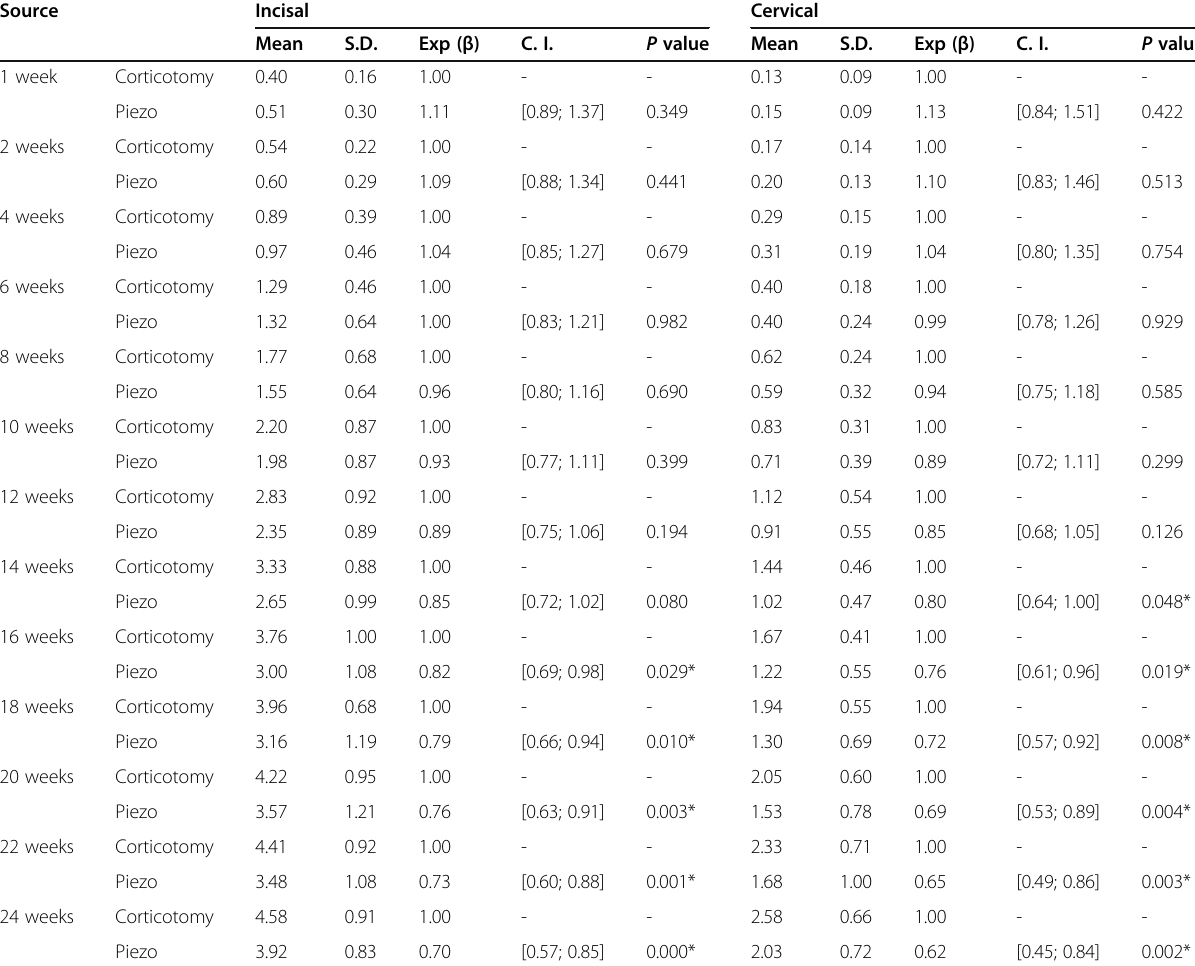
Table 4 Comparison of incisal and cervical accumulative moved distances (mm) between sides over time - group 3